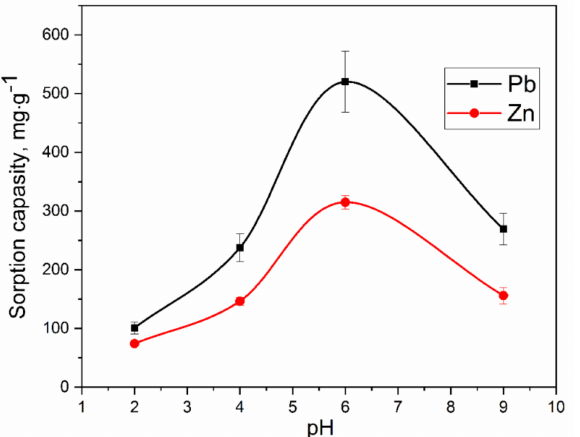
Figure 7. The influence of pH of aqueous solution on the sorption of lead and zinc ions in buffer